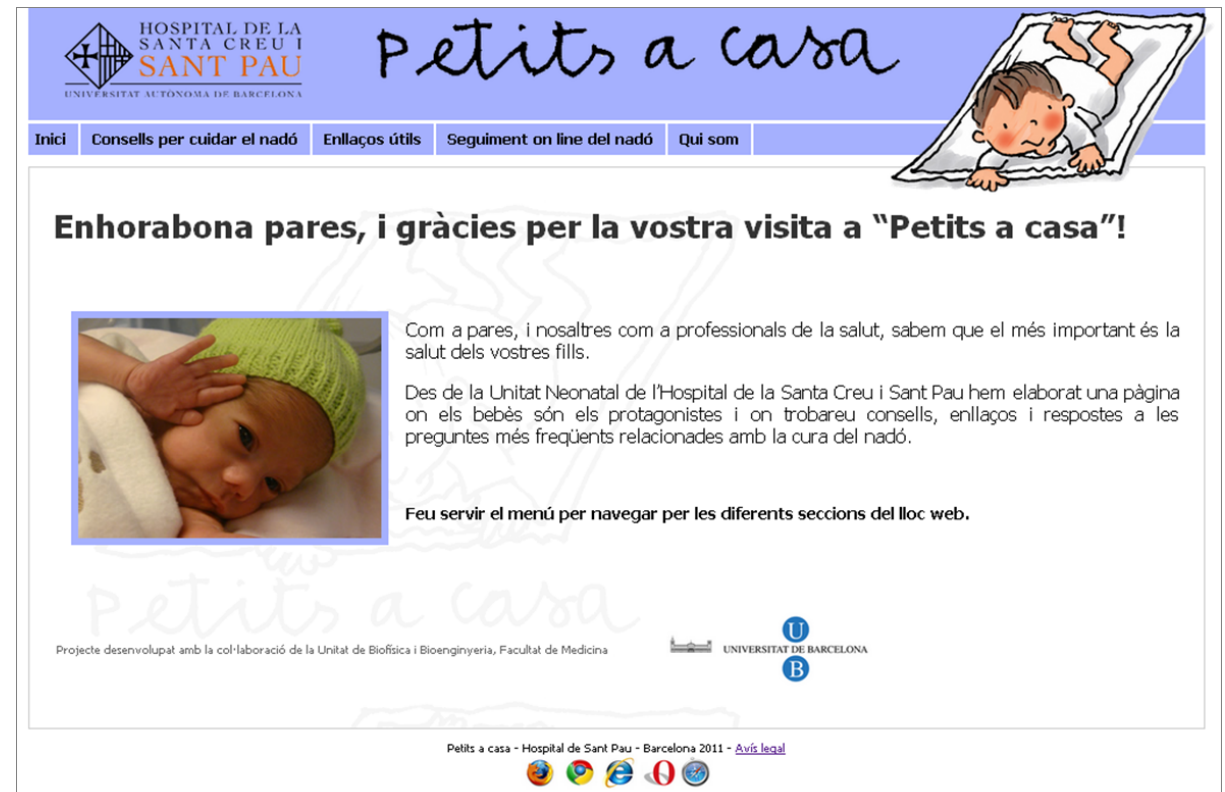
Figure 1. “Babies at home” home page